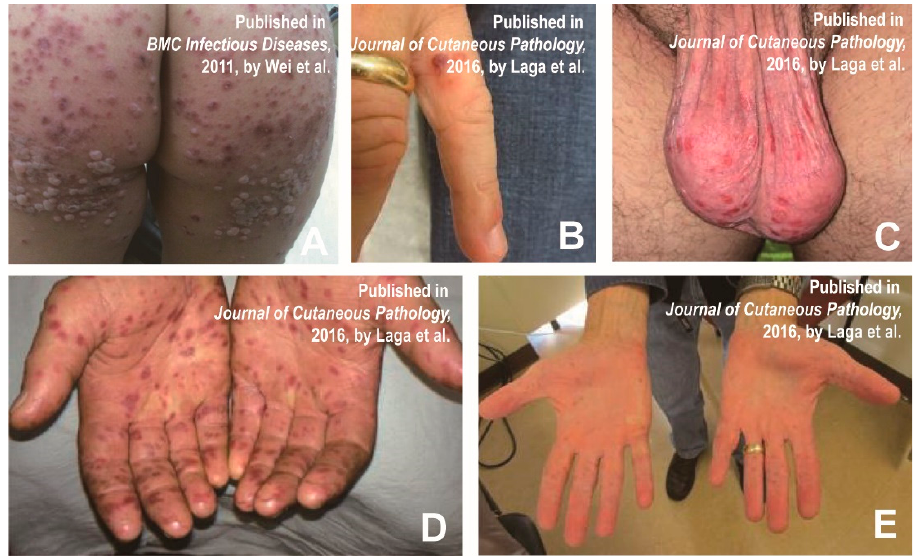
Figure 3. ( A ) A boy experienced prominent skin eruptions and vesicles on his buttocks.